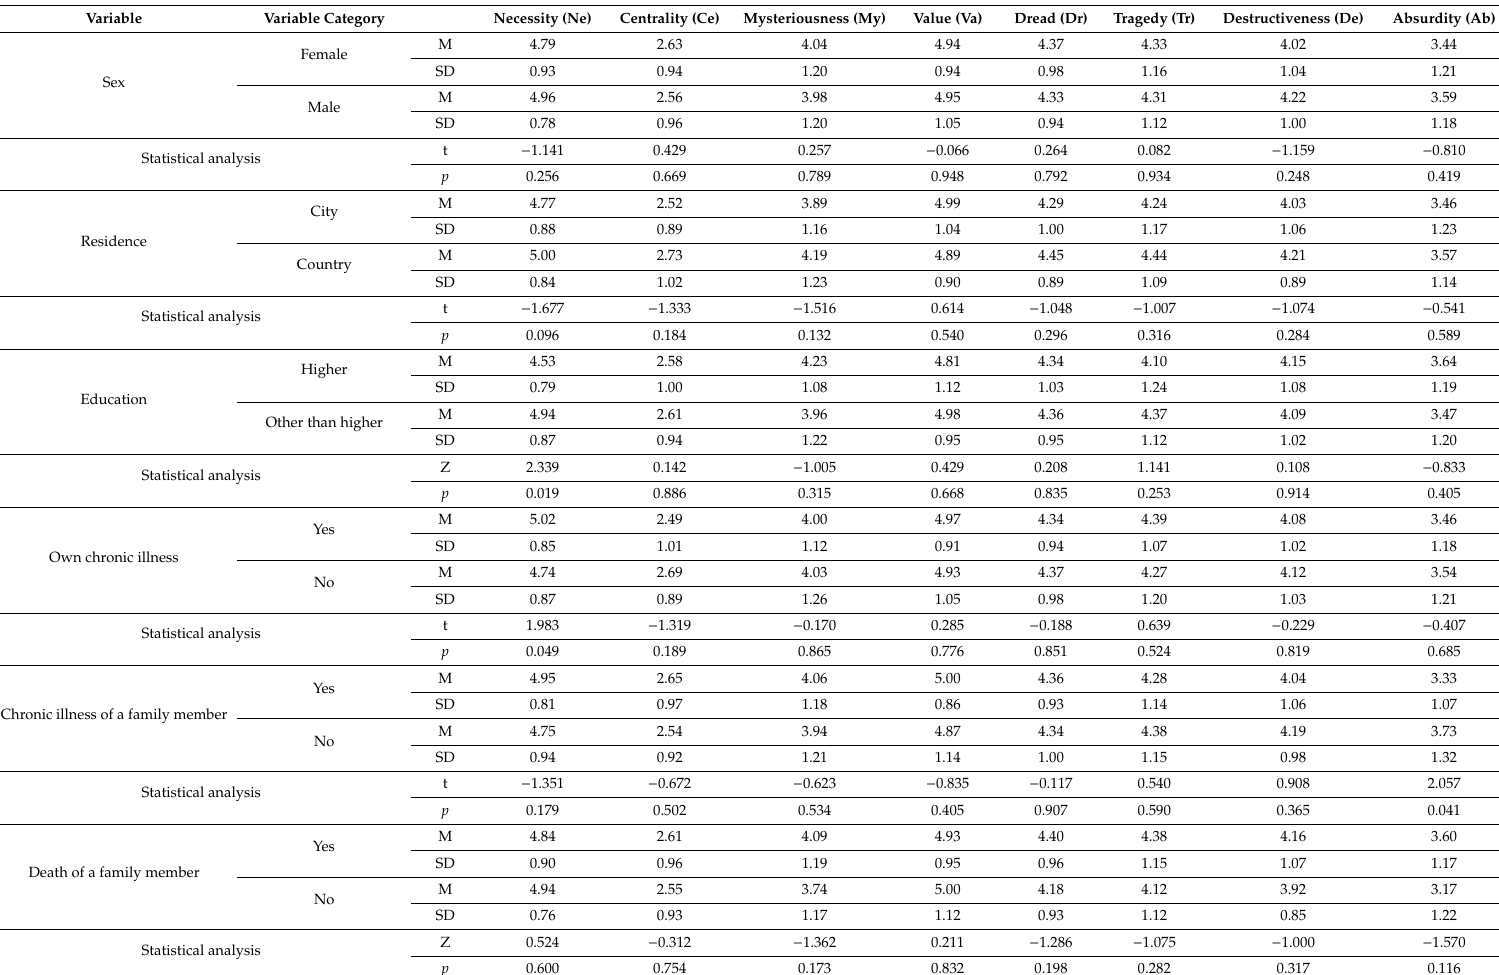
Table 2. Dimensions of attitudes towards death in the investigated cohort of